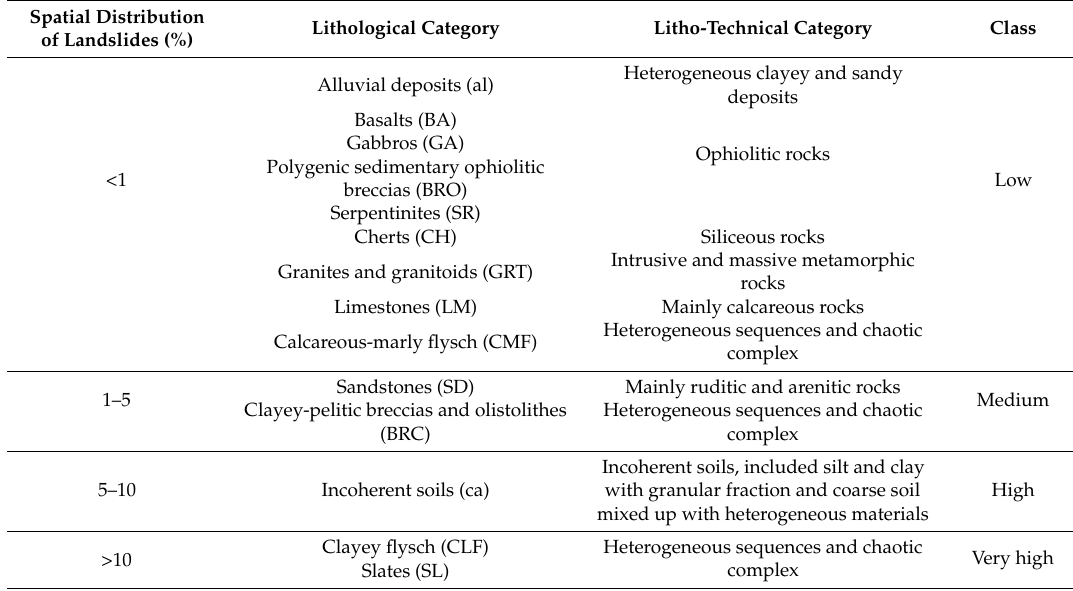
Table 4. Reclassification of the lithological categories based on the statistical distribution of landslides (%) (see also Figure 9) related to the litho-technical features of different materials and their extent in the catchment area.